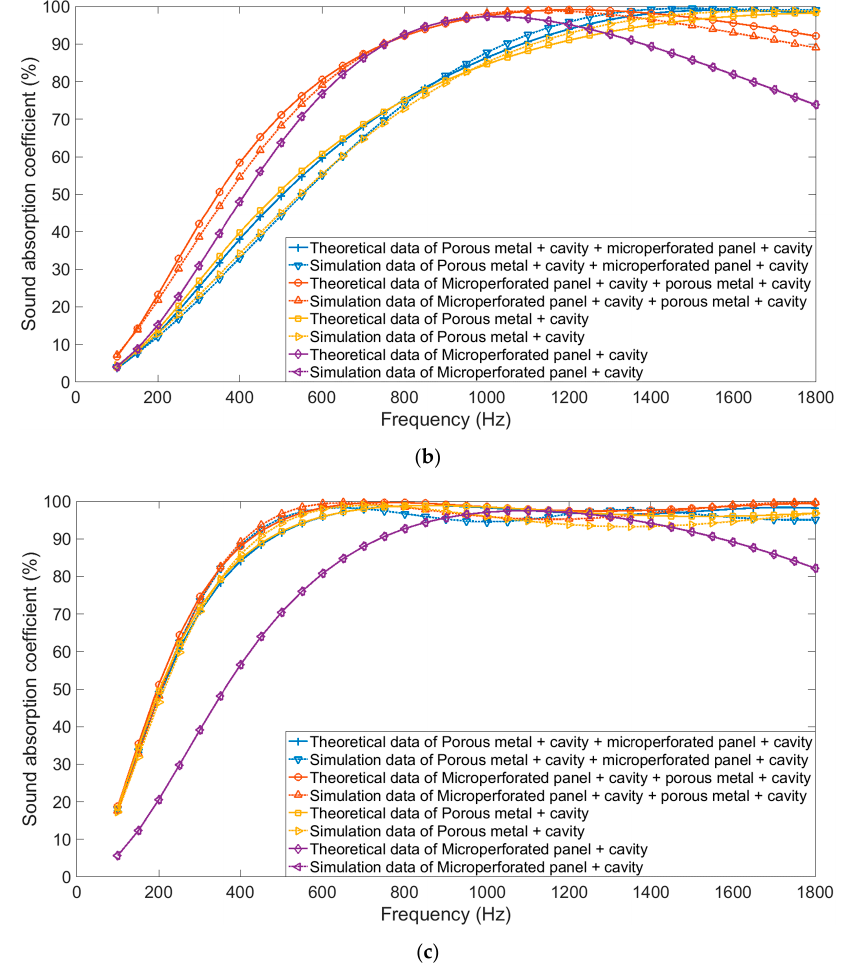
Figure 4. Comparisons of the theoretical results and simulation results of sound absorption coefficients of the four investigated sound absorbers with different limited total thicknesses. ( a ) 30 mm; ( b ) 50 mm; ( c ) 100 mm.